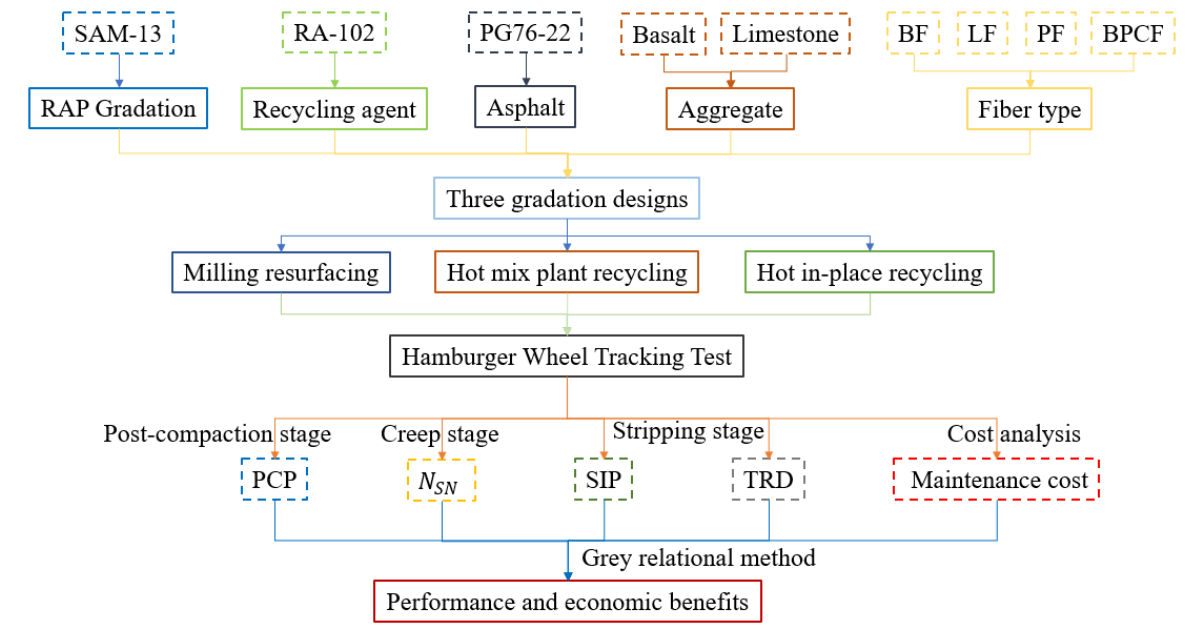
Figure 1. Flowchart of the research.